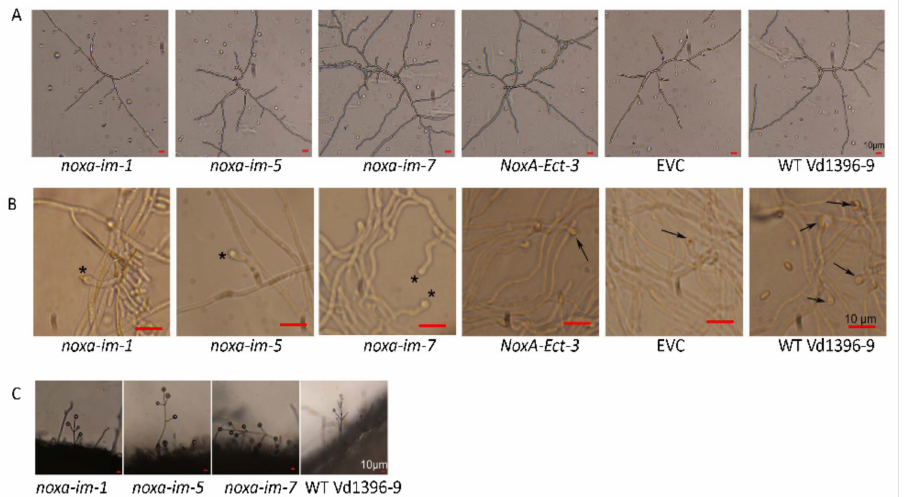
Figure 8. Morphology of noxa mutants in germination, penetration, and formation of conidiophores. ( A ) Conidia germination ability test of noxa mutants on cellophane membrane at 24 h. The conidia of noxa mutants and the wild type strain (WT Vd1396-9) were cultured on cellophane membrane